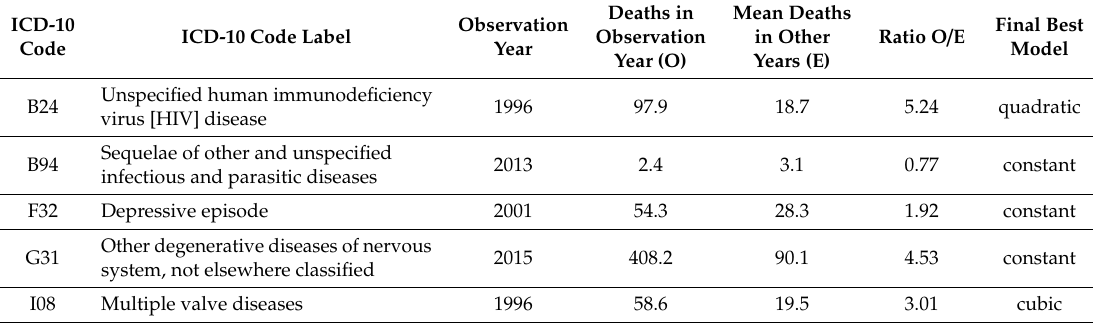
Table 2. Distribution of the final best model of ICD-10 Causes of Death at different levels of aggregation. Table 3. Causes of death (ICD-10 three-position) with a detectable mortality fluctuation at the alpha 0.001